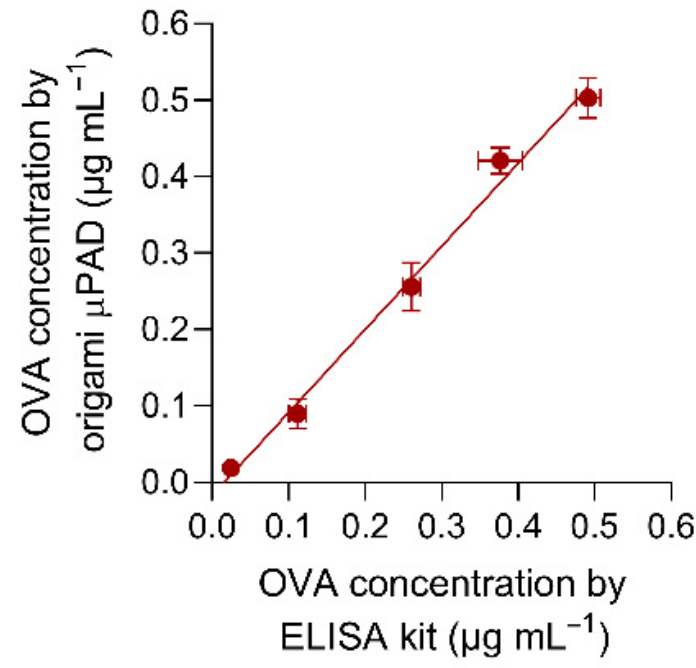
Figure 10. Comparison between OVA concentrations measured in real samples by using the origami µ PAD and the colorimetric ELISA kit reference method. The equation of the linear regression curve is Y = 1.087 X − 0.018 (R 2 = 0.992), where Y and X are the OVA concentrations measured with the origami µ PAD and the colorimetric ELISA kit reference method, respectively. Each of the data are the mean ± SD of three measurements.